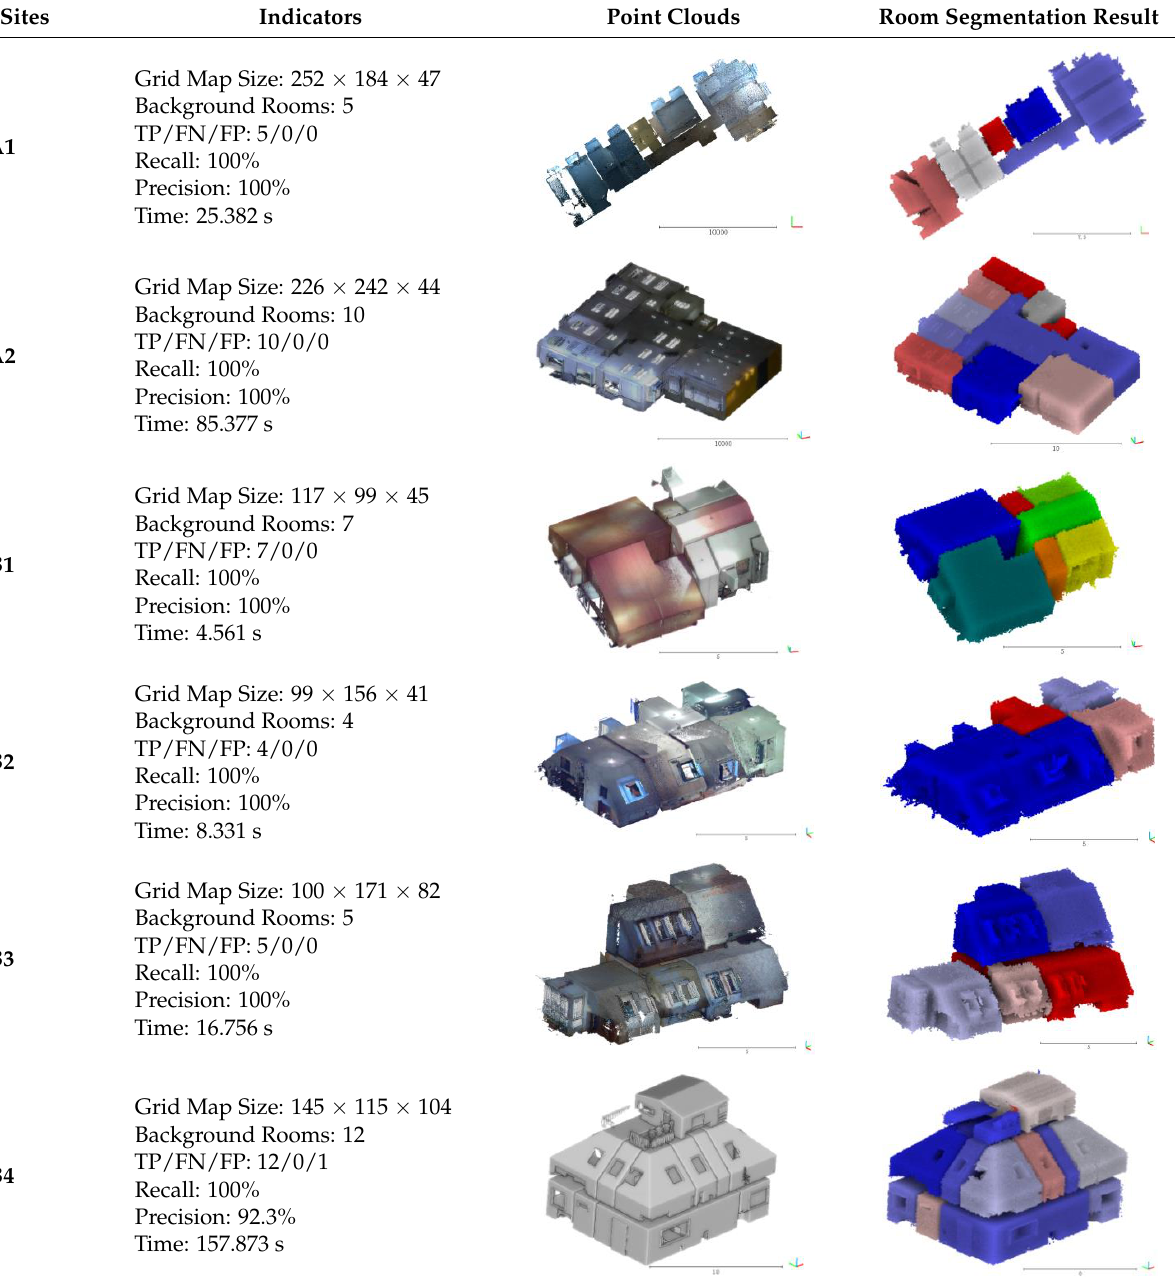
Table 3. Indicators and room segmentation results of the proposed method for real-world datasets. Test Sites Indicators Point Clouds Room Segmentation Result